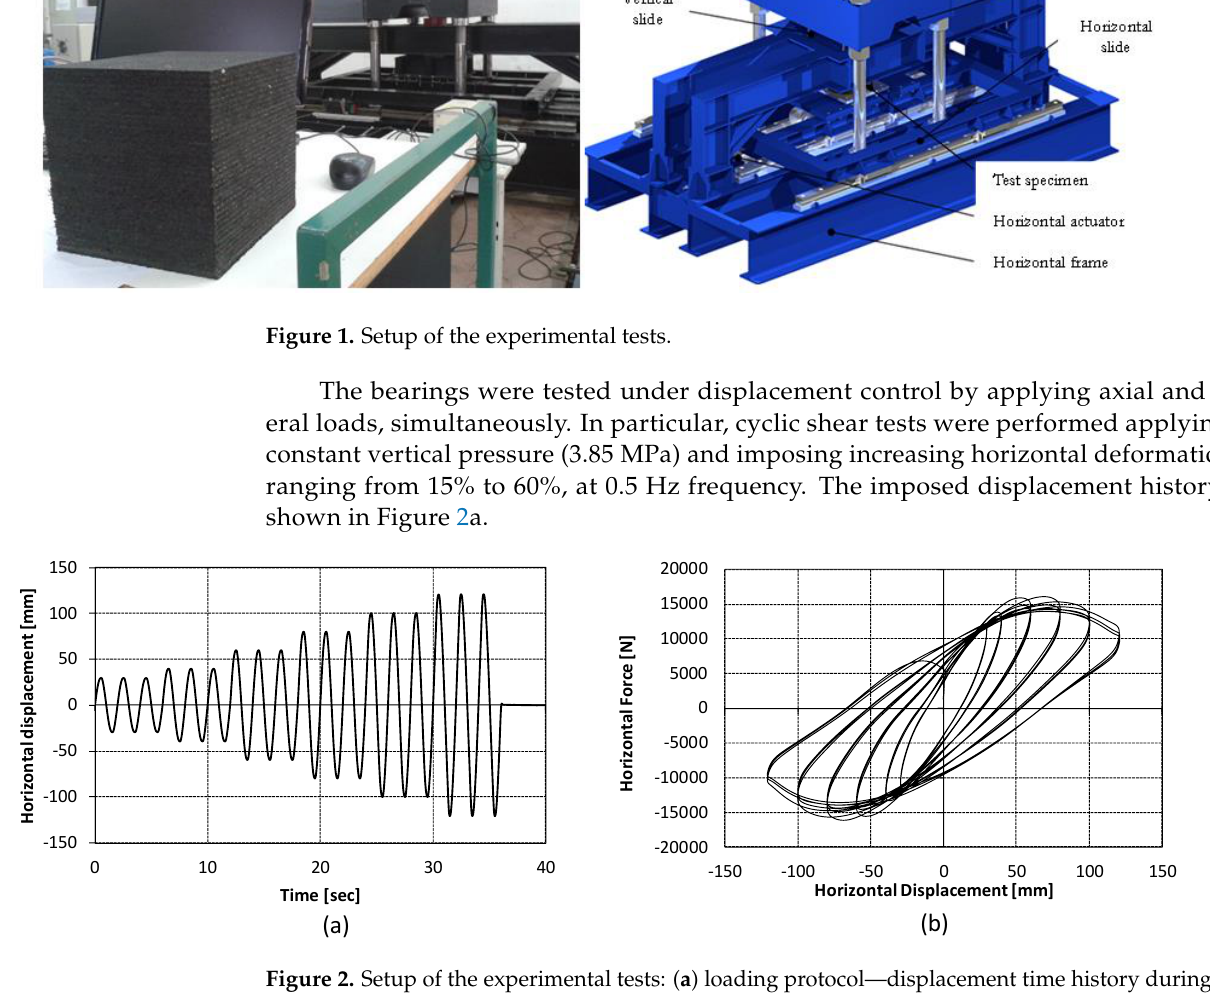
Figure 2. Setup of the experimental tests: ( a ) loading protocol — displacement time history during the shear testing; and ( b ) force vs displacement response of the full-scale RR – FRB. As is clearly pointed out by the experimental hysteresis loops of Figure 2b: (i) the bearings show little degradation after many cycles of deformation, (ii) for small lateral deformations, the response of the devices is close to linear, and (iii) the device exhibits a negative tangent stiffness for shear deformations larger than 40% (softening